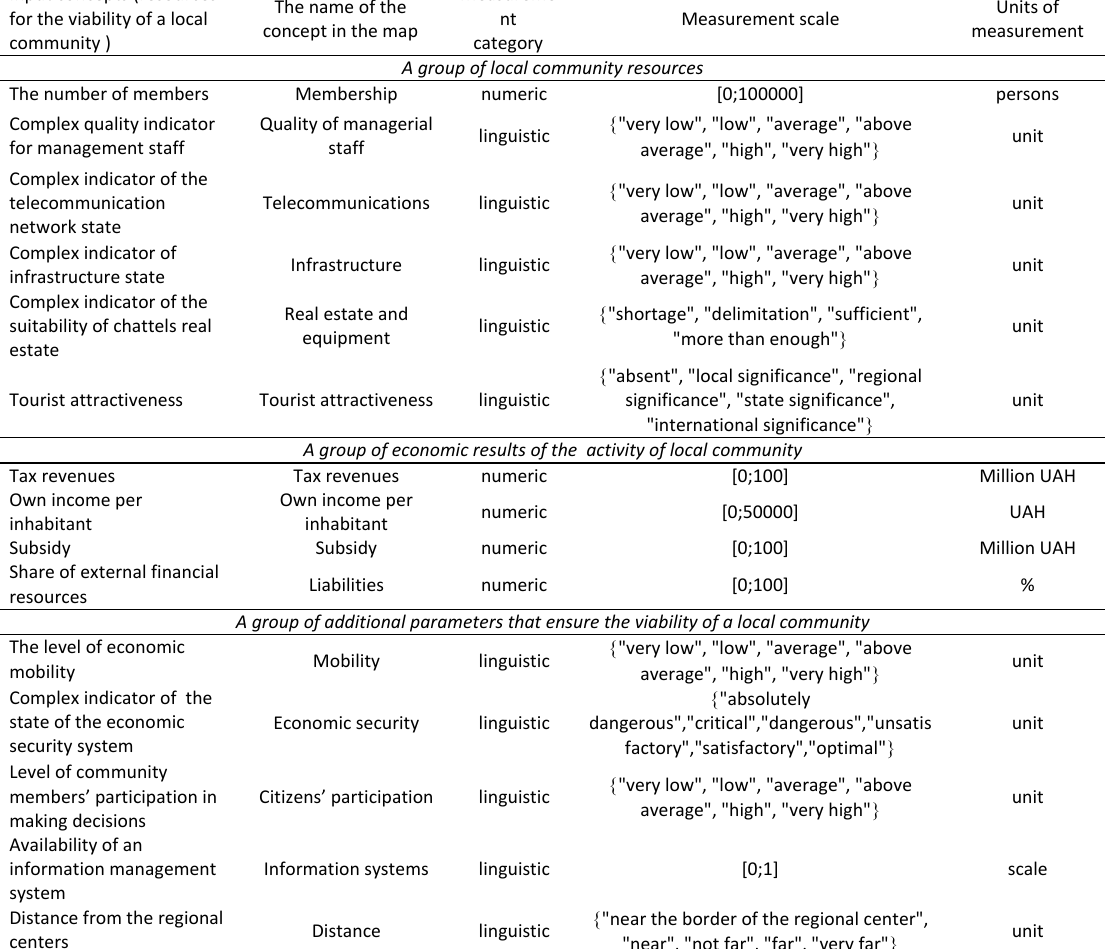
Input concepts (resources for the viability of a